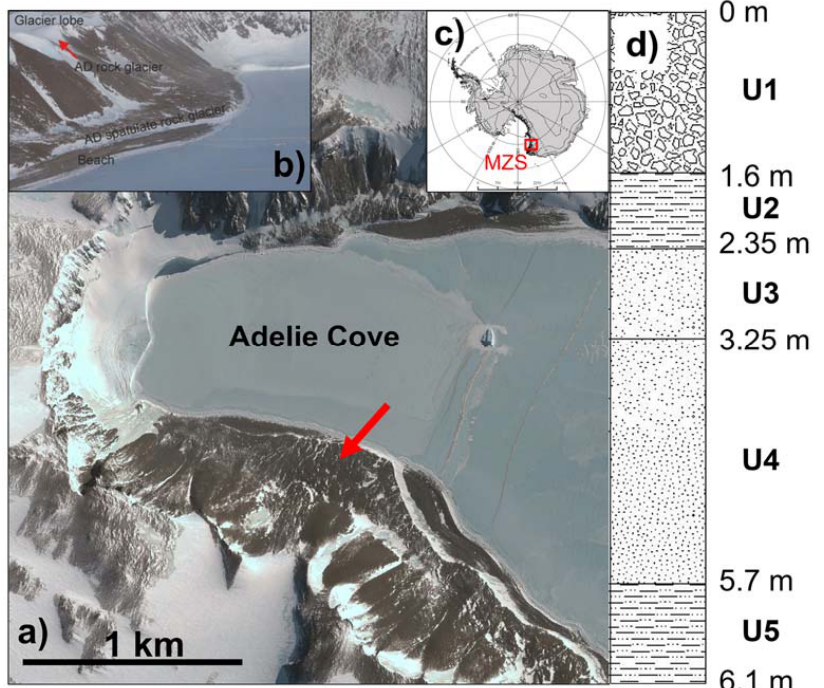
Figure 1. Location map. ( a ) satellite photographs (courtesy Google Earth © DigitalGlobe 2016); ( b ) Adélie Cove South: from the sea to the upward margin, the raised beach, lower spatulate rock glacier, and the AD rock glacier can be seen; ( c ) map of Antarctica showing the location of the study area; ( d ) permafrost core stratigraphy.